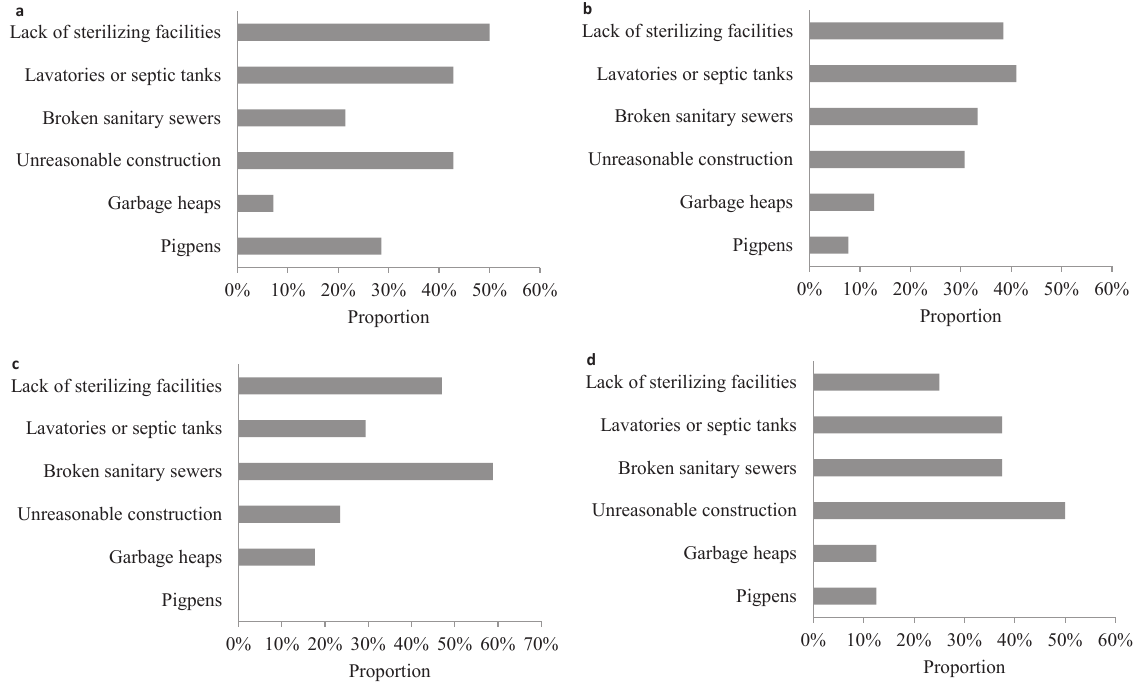
Fig. 4. Proportions of sanitary conditions of wells and its surroundings in a) central China, b) eastern China, c) western China, and d) northeastern